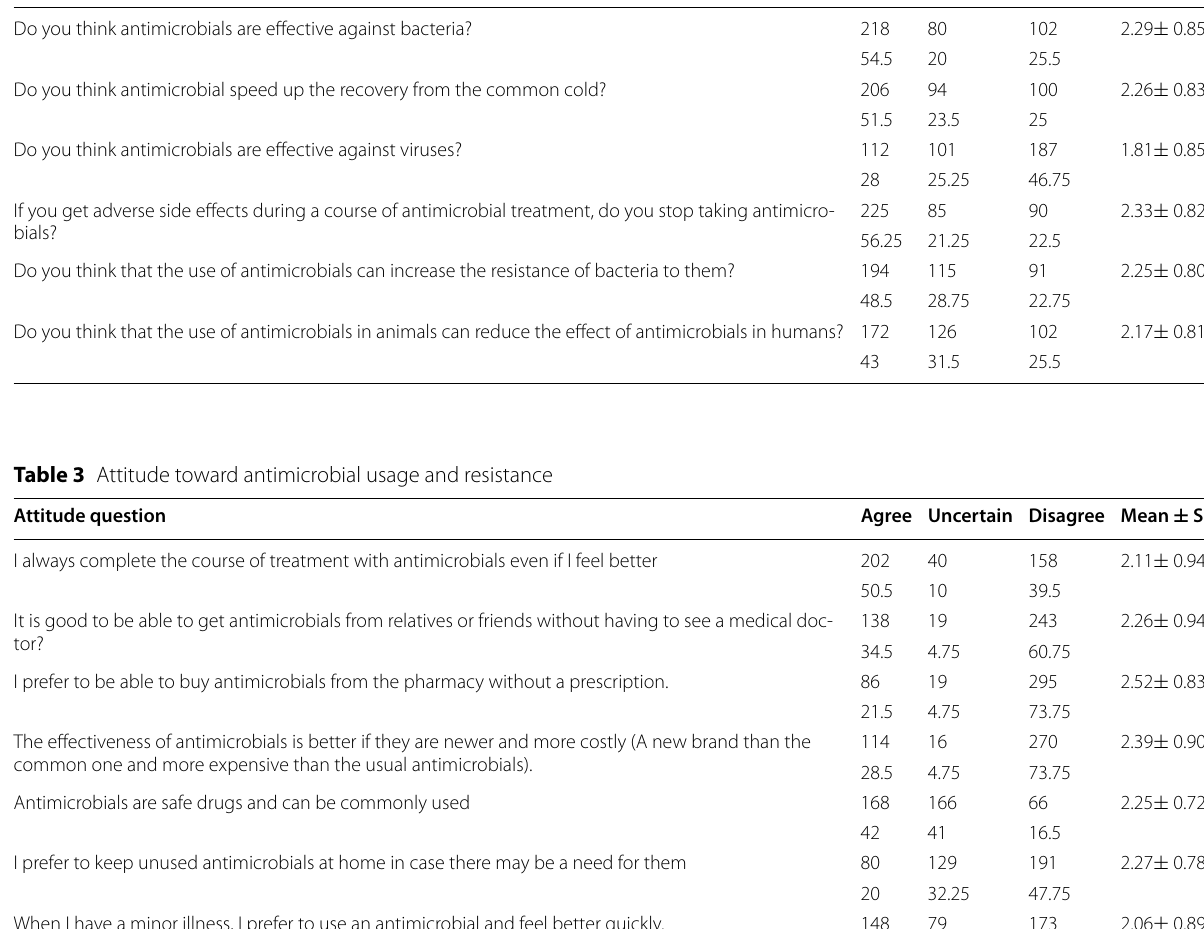
Table 2 Knowledge of respondents about antimicrobial usage and resistance Knowledge question